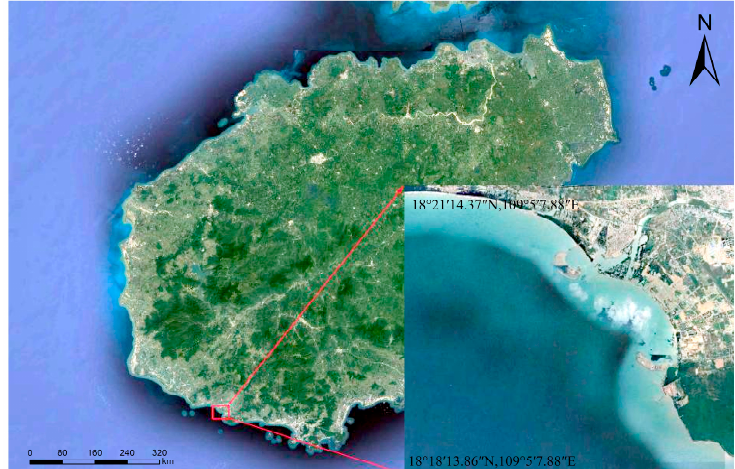
Figure 1. Location Map of Nanshan Port.